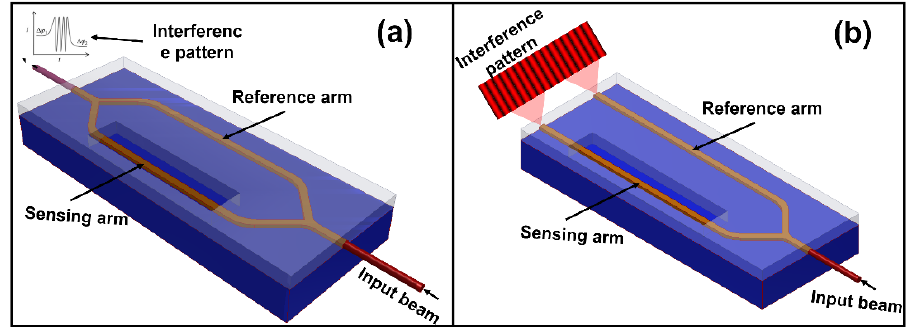
Figure 1. Interferometric biosensors. ( a ) Scheme of a standard Mach-Zehnder interferometer. The light is split into two arms and recombined at the output by on-chip Y-junctions. ( b ) Scheme of a standard Young interferometer. Rather than using Y-junctions to merge the split beams, the light is projected from two closely spaced secondary sources onto a display device.